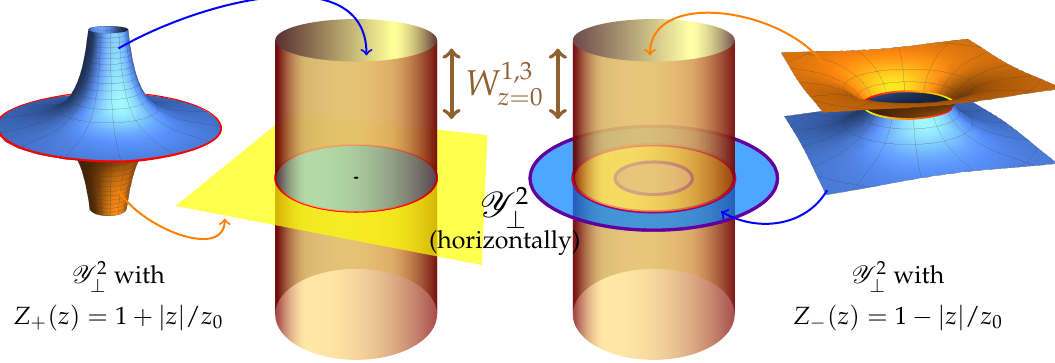
Figure 2. A depiction of the W 1,3 z (cid:111) Y 2 ⊥ fibration with Z + ( z ) ( left ) and W 1,3 z (cid:111) Y 2 ⊥ with Z − ( z ) ( right ). Far left and far right: the proper distance plotted vertically in Y 2 ⊥ , indicating the radial dependence of the circumference—which is obscured in the two central depictions. Only the mid-radius fiber, W 1,3 , of the fibration W 1,3 z (cid:111) Y 2 ⊥ is depicted as a vertical cylinder, z = 0 × S 1 ; it defines the “inside” and “outside’ part of the six-dimensional spacetime’; see (7), W 1,3 z = 0